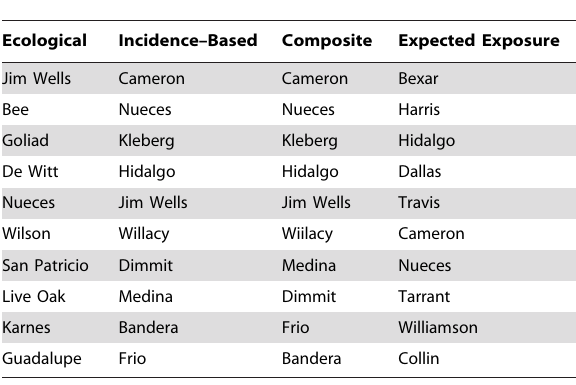
Table 2. High Chagas risk counties in